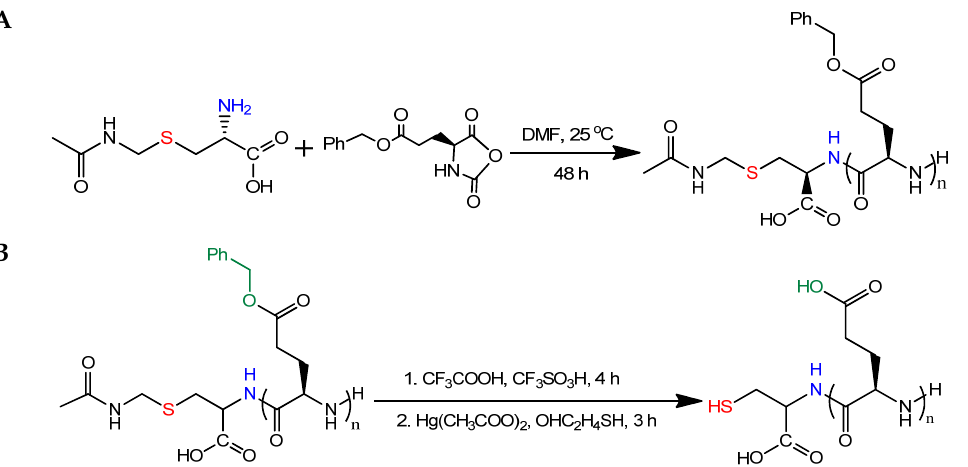
Figure 2. Scheme of synthesis of PGlu containing a terminal SH-group: ( A ) ROP and ( B ) deprotection.